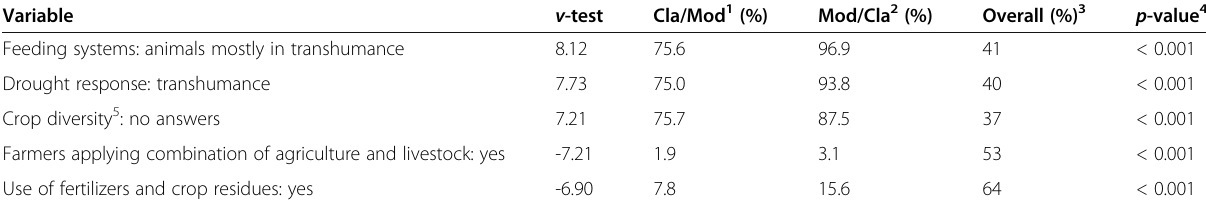
Table 5 Top 5 relevant categorical variables that best describe the 32 farms from cluster 2. Overall sample n = 100 farms